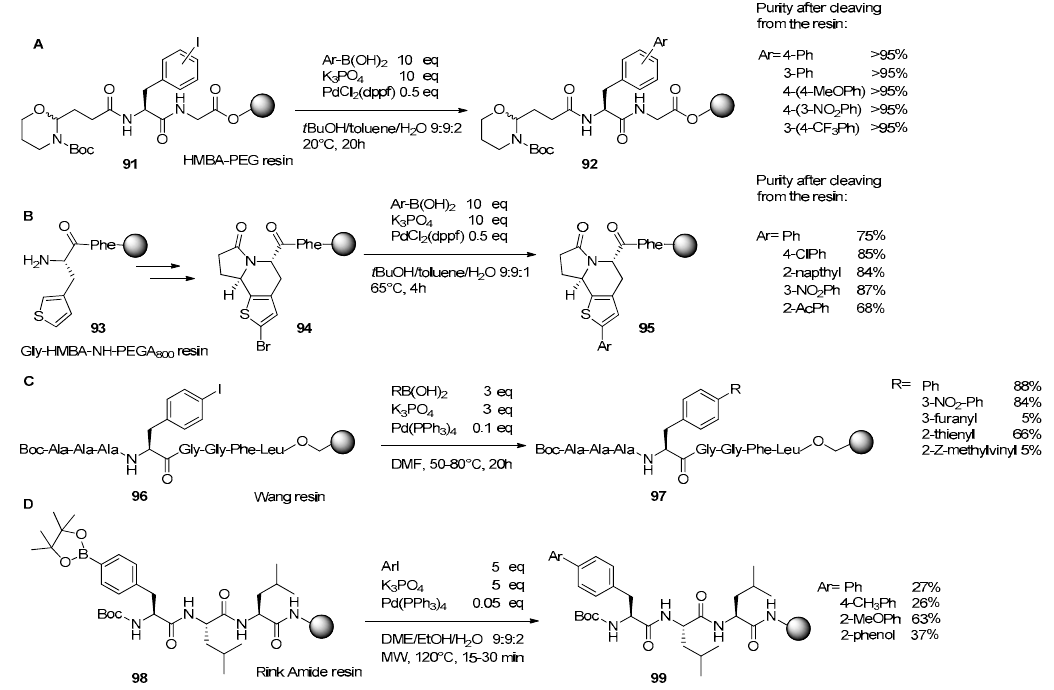
Figure 14. Solid-Phase derivatization via Suzuki–Miyaura cross-coupling ( A ) with iodophenylalanine containing 91 , ( B ) with bromothienylalanine containing 94 , ( C ) with 4-iodophenylalanine containing octapeptide 96 , and ( D ) with tripeptide 98 bearing pinacol protected 4-borono- L -phenylalanine.